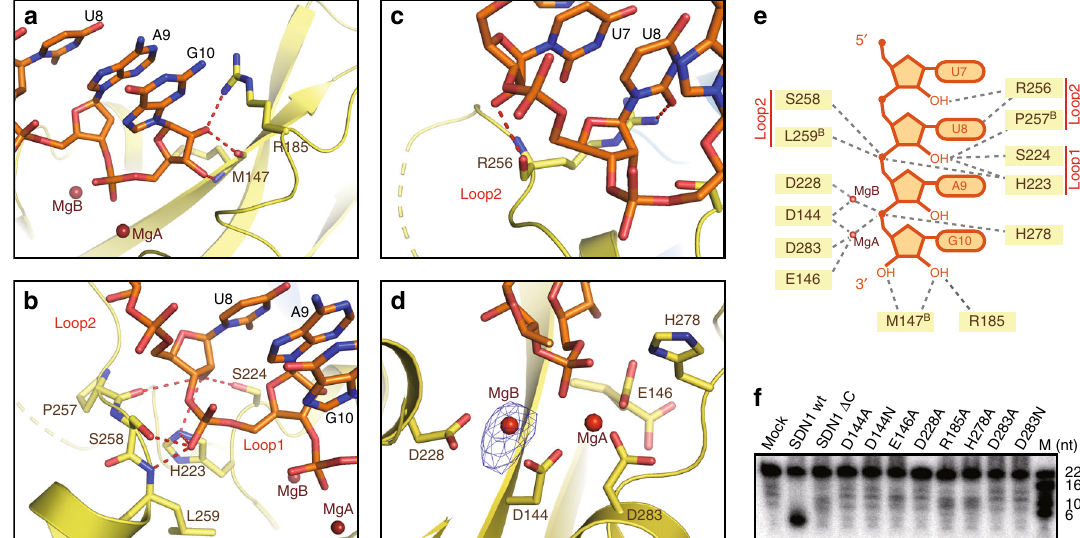
Fig. 2 The SDN1 catalytic pocket and mechanisms of its RNA recognition. a – c Interactions between the SDN1 catalytic pocket and the four nucleotides from the 3 ′ end of the RNA. Hydrogen bonds are colored in red. d Active center of SDN1. Two magnesium ions are shown with the simulated annealing Fo-Fc omit map (contoured at 5.0 σ level), and there is no electron density for MgA due to low occupancy. e Schematic drawing of the interactions between the SDN1 catalytic pocket and the RNA substrate. f In vitro enzymatic activity assays with wild-type SDN1, SDN1 Δ C, and various SDN1 mutants. Wild-type SDN1 can degrade the free miRNA into products of a very small size. SDN1 Δ C and the mutants are defective in enzymatic